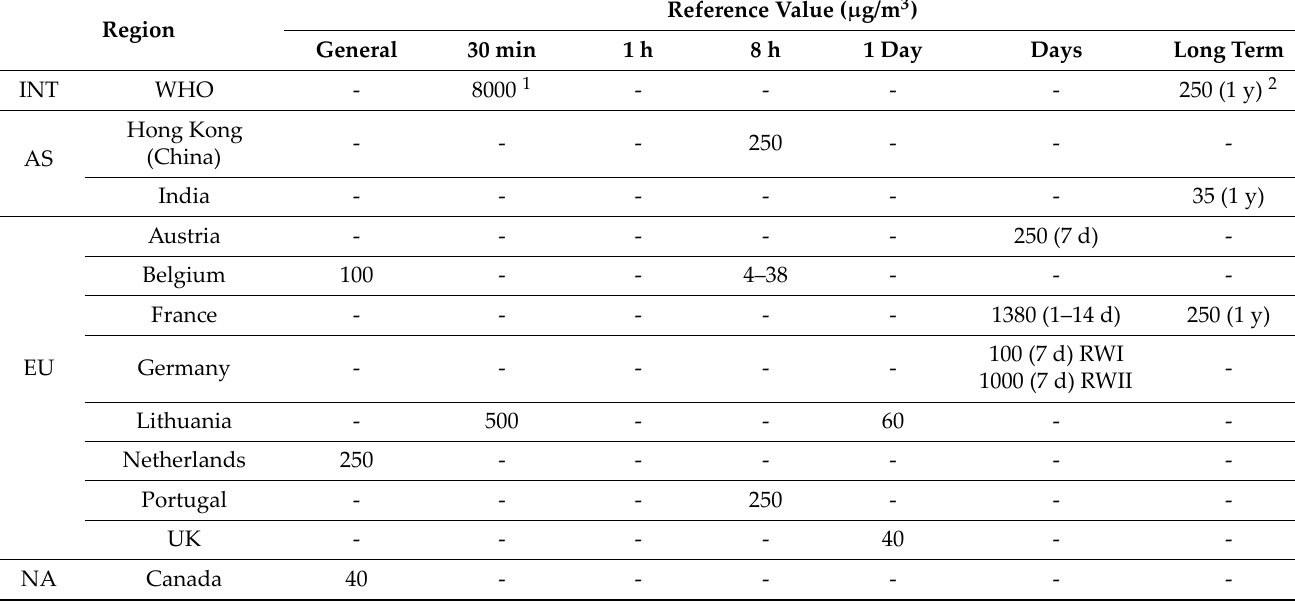
Table 18. Reference values for